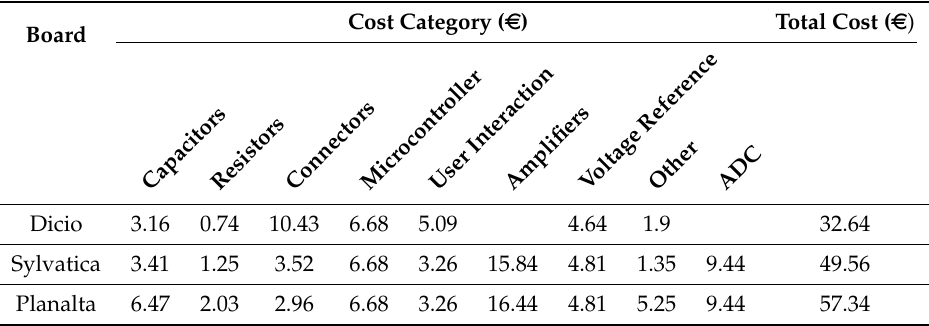
Table 4. Cost calculation assuming ten boards are produced of a particular type. The cost calculation is based on the Mouser inventory and component prices of 17 December 2019. Enclosure is optionally available from Hammond Manufacturing for 20.21 e . All prices are excluding VAT.